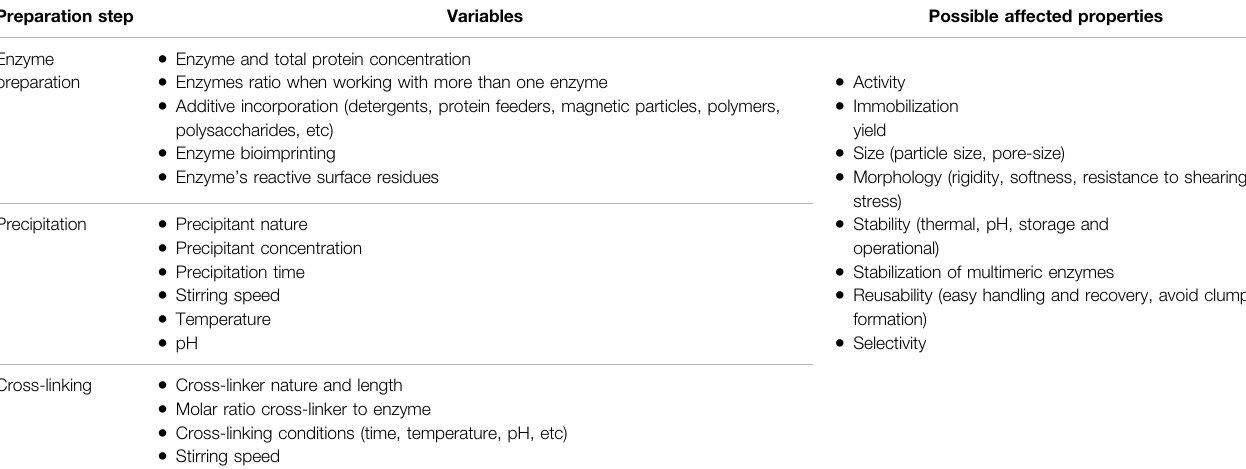
TABLE 1 | Parameters governing CLEA ’ s main properties. Preparation step Variables Enzyme